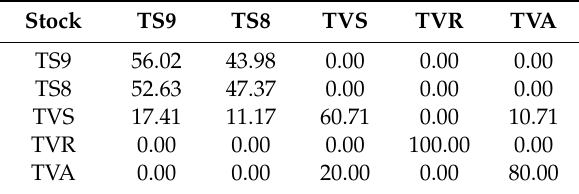
Table 4. Results of the individual self-assignment test computed using GeneClass2 software [40]: Results are presented with percent score of most likely source (threshold p < 0.05).